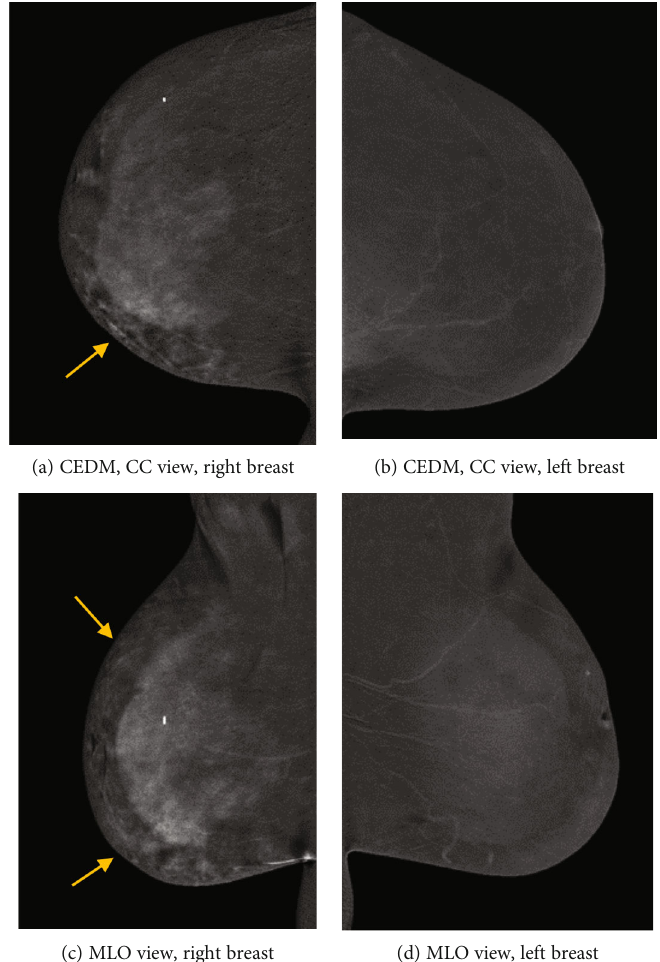
Figure 3: (a – d) Bilateral recombined images in a craniocaudal (CC) and medial oblique (MLO) views. There is minimal background parenchymal enhancement. Marked nonmass enhancement is noted predominantly within the inner aspect of the right breast, especially in the subcutaneous peripheral areas (yellow arrows, (a,